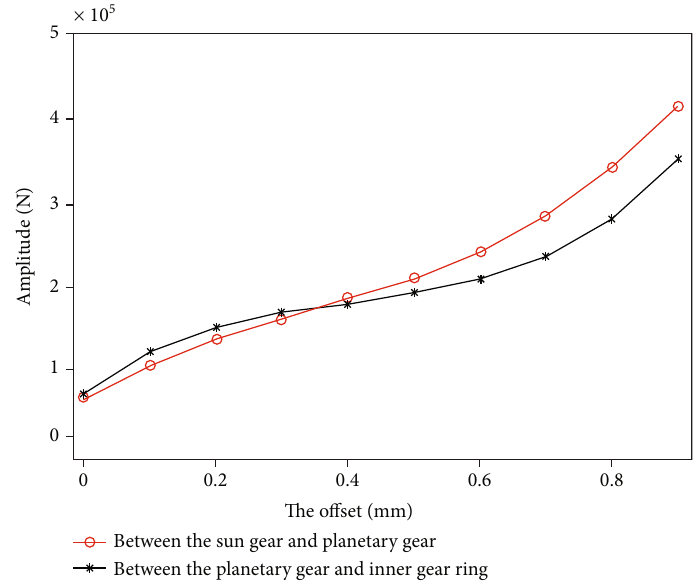
Figure 13: The variations in the average meshing force of the gears with di ff erent o ff sets.